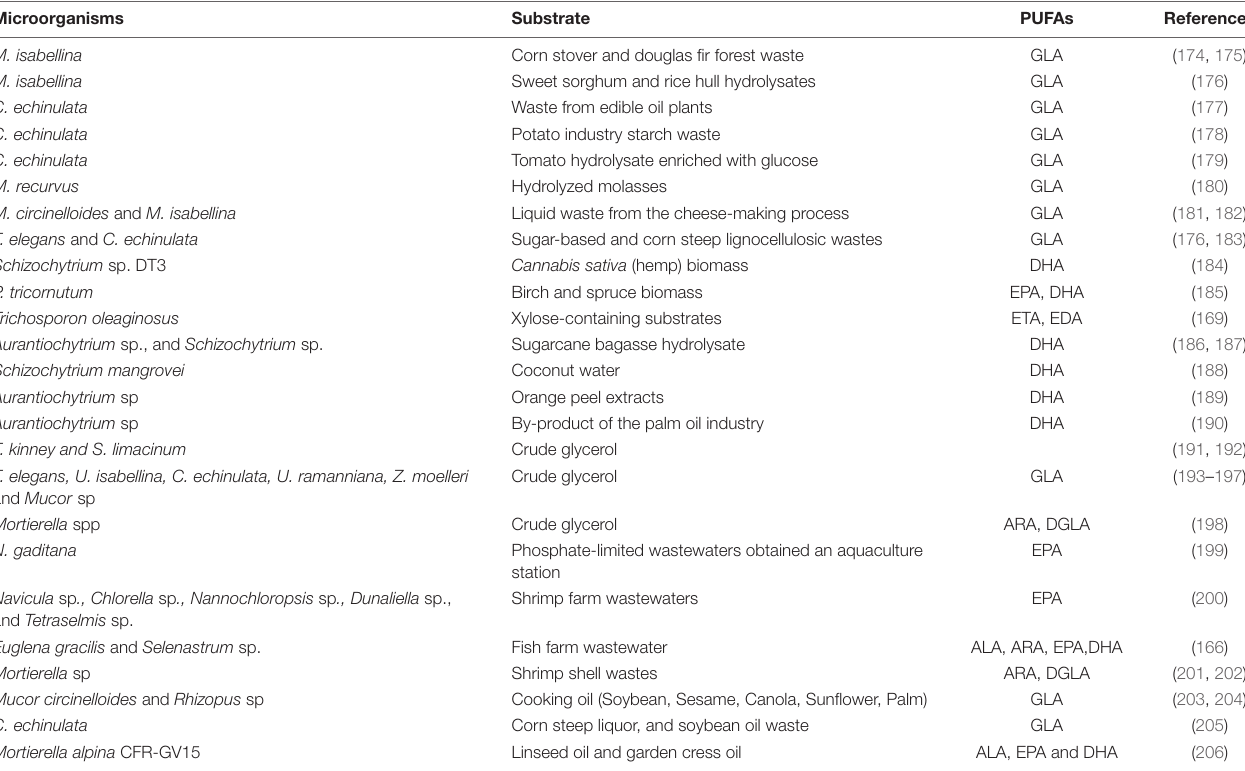
TABLE 4 | Summary of bioconversion of agro-industrial wastes into high-value single cell oil by oleaginous